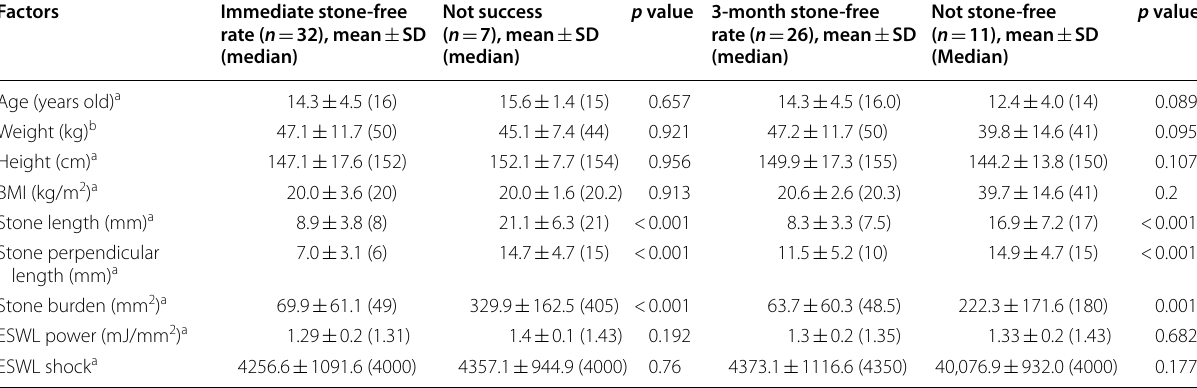
Table 5 Statistical analysis results between numerical variables, immediate success, and 3-month stone-free